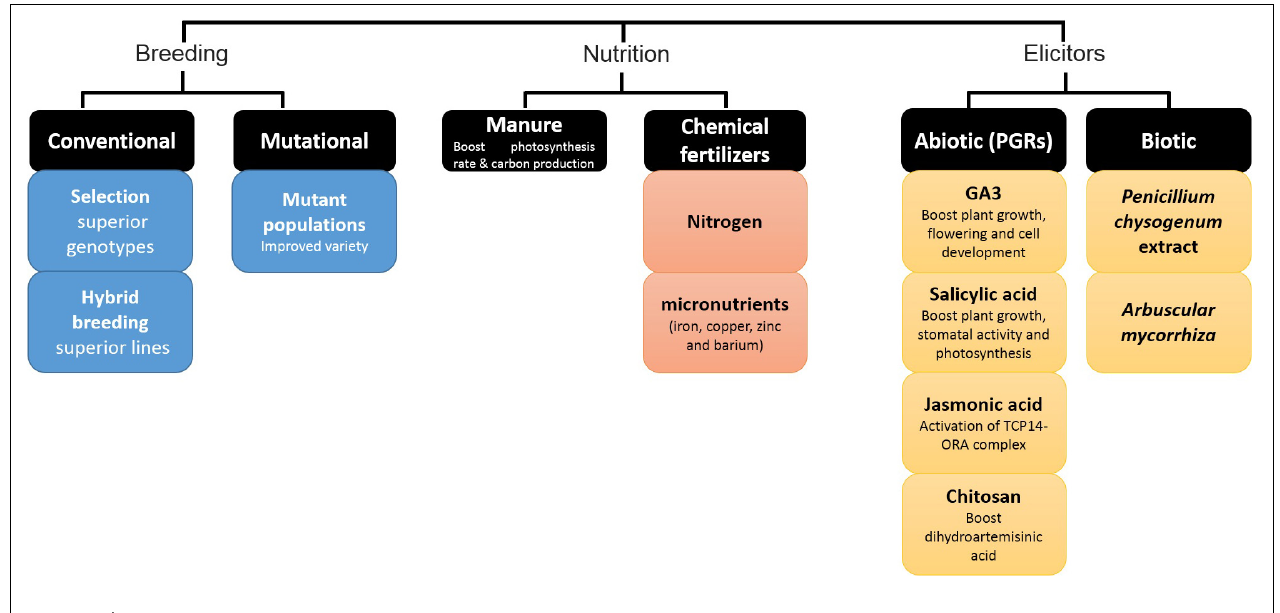
FIGURE 4 | Classical methods to improve artemisinin production in Artemisia annua.